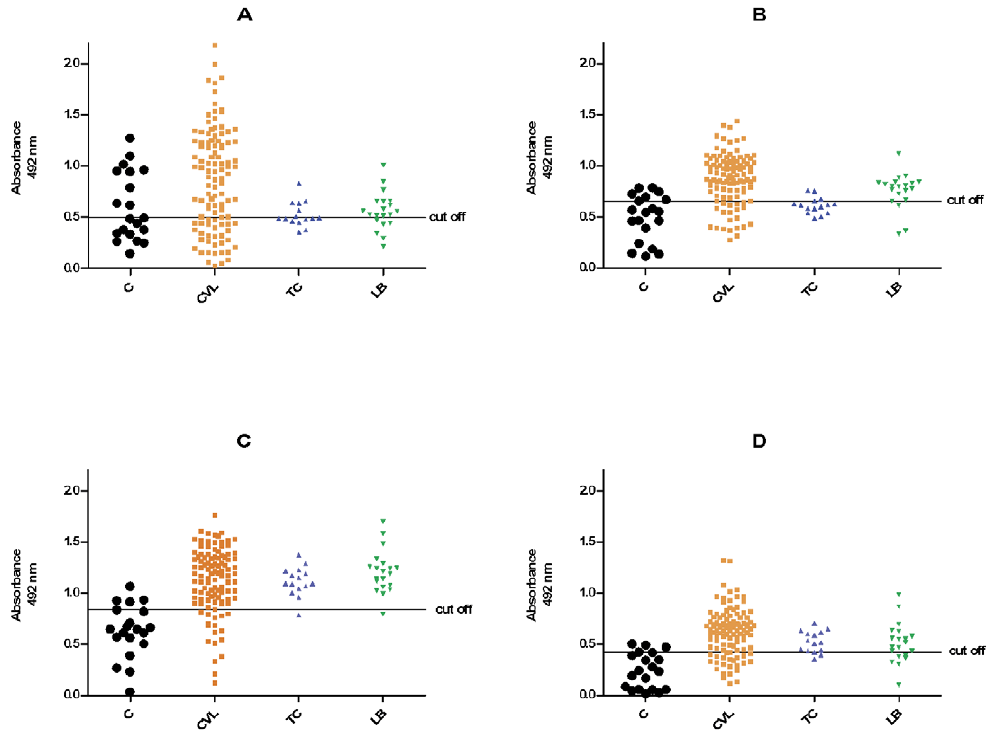
Figure 1. Comparison of ELISA reactivity of canine sera against PSLc6, PSLc8, PSLc10 and Mix10. ELISA was performed in different groups of dogs (C, control group, n=20; CVL, L. infantum group, n=107; TC, T. cruzi group, n=15; LB, L. braziliensis group, n=20) against PSLc6 (A), PSLc8 (B), PSLc10 (C) and Mix10 (D).